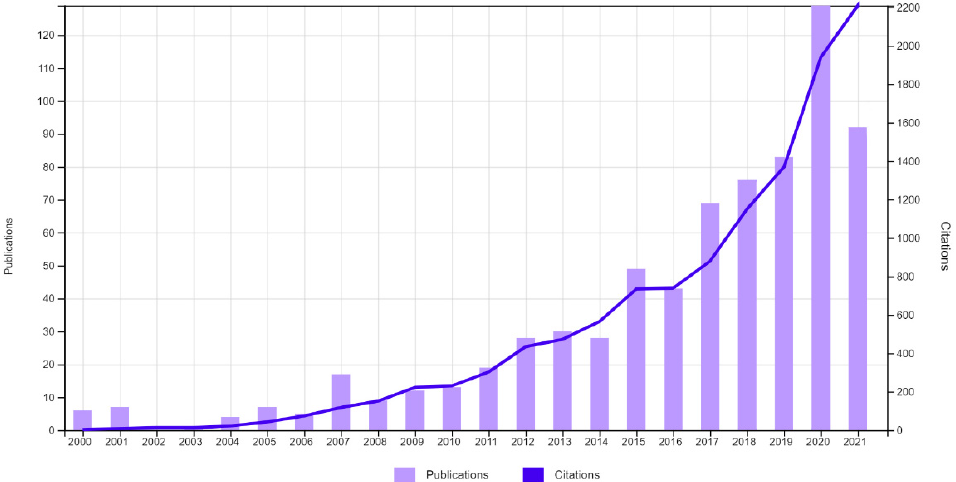
Figure 3. Number of publications and citations per year. Source: Web of